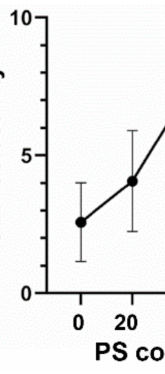
Figure 3. The optimization of PS ratio. The liposomes with lipid compositions of EPC/PS/Chol (50-X/X/50, moral ratio) were intratumorally administered into tumor-bearing mice. SLN selectiv- ity was determined by calculating SLN accumulation/axillary LN accumulation. Data represent mean ± standard deviation ( n =